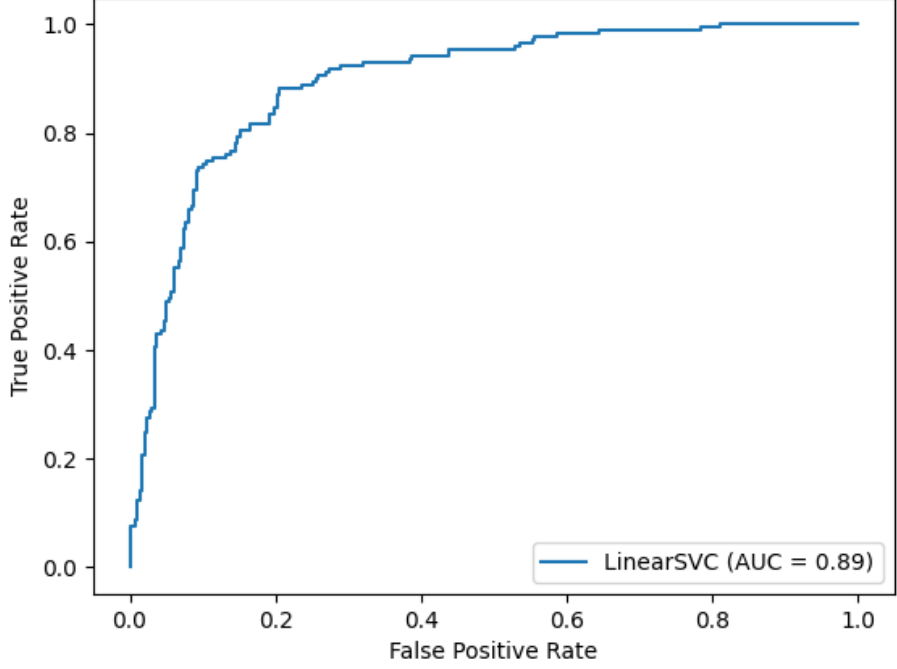
Figure 1. The ROC (Receiver Operating Characteristics) curve of the Budapest Amyloid Predictor. The AUC (Area Under Curve) value is 0.89. The precision-recall curve is provided as Figure S1 in the supporting